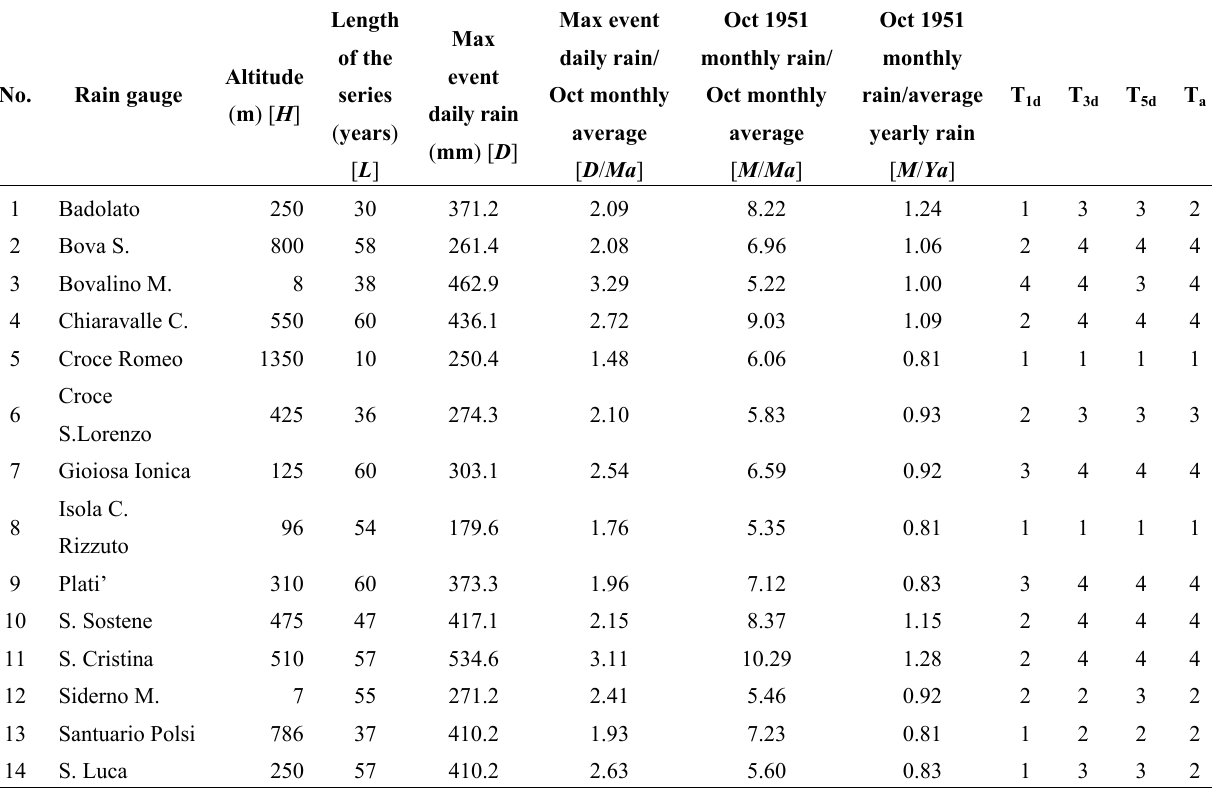
Table 2. Rain at the gauges that recorded the maximum daily rain during the event, indicated by stars in Figure 2A. Classified values of return periods are indicated with T (for 1-day rain recorded during the event), T (for 3 days), and T (for 5 days), whereas T 3d 5d is the average of T , T and T 1d 3d 5d